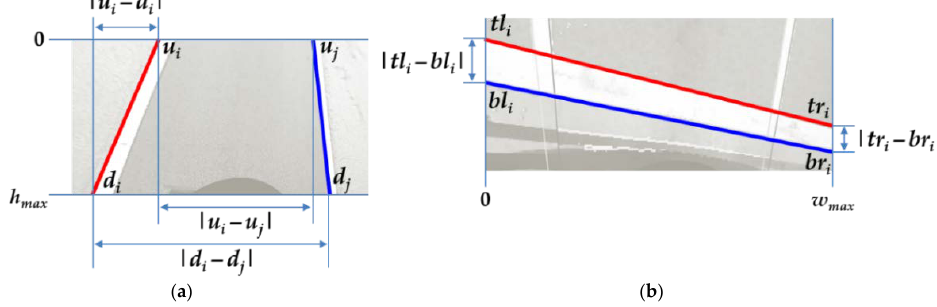
Figure 9. Explanations of cost functions used for the LM algorithm. ( a ) In the case of a lane marking; ( b ) In the case of a stop line.